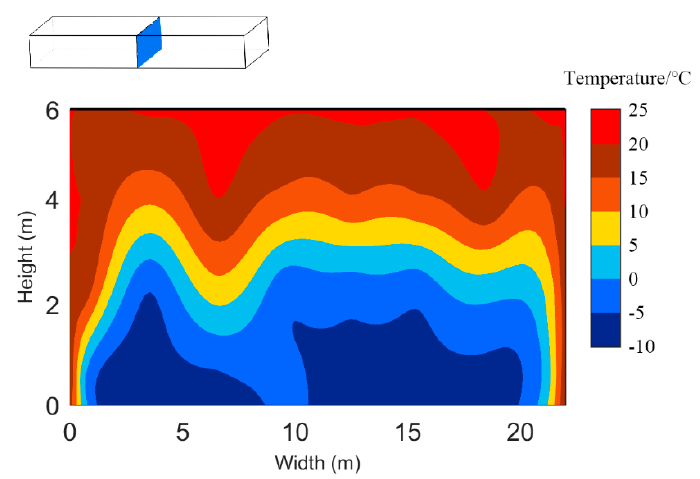
Figure 6. Temperature distribution of stored grain as a cross section on 26 July 2018. The upper left corner is the schematic diagram of the selected cross section.